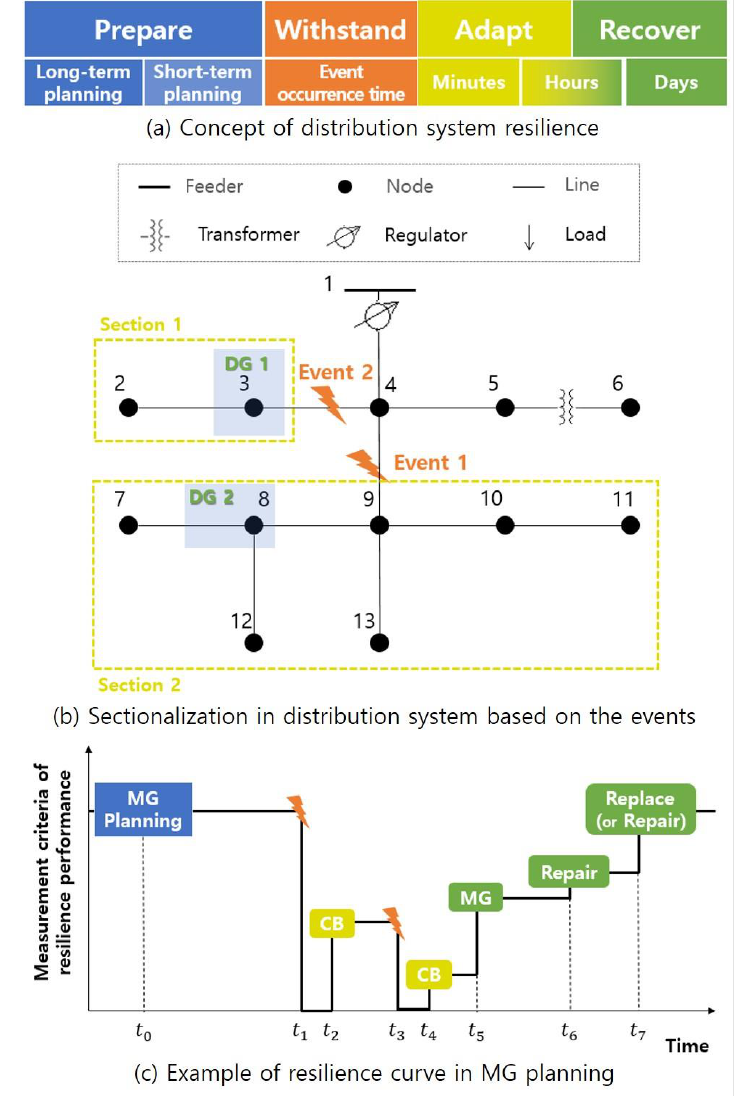
Figure 3. Example of resilience curve estimation.